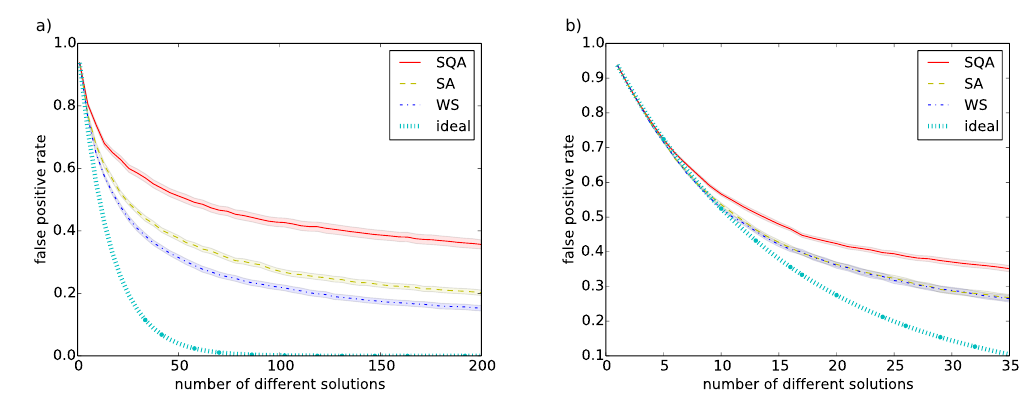
Figure 2: Average FPR of a filter constructed from solutions found by each solver within 2000 runs. The average is taken over 20 randomly generated 4-SAT instances with n = 50 variables ≈ 8.06. a) The solutions used to construct the filter are and a clauses-to-variables-ratio of α χ 4 chosen randomly from the found solutions. b) The solutions used to construct the filter are chosen so that they maximize the average pairwise Hamming distance between the chosen solutions. The dotted cyan line shows the theoretical FPR for a filter constructed from truly independent solutions.